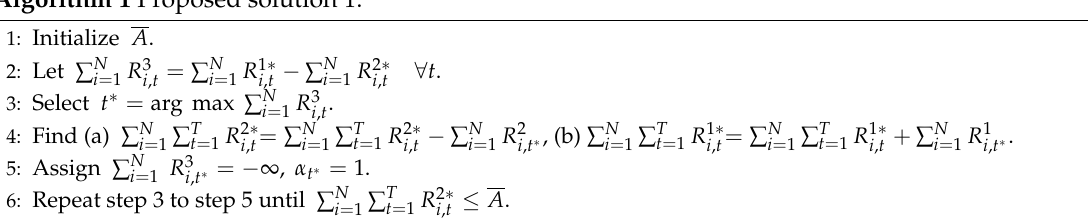
Algorithm 1 Proposed solution